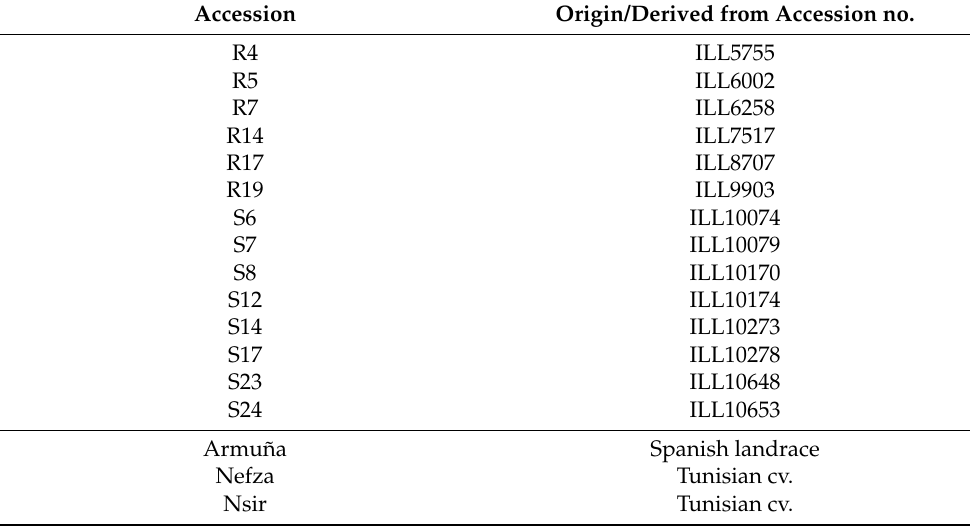
Table 1. Lentil accessions included in the